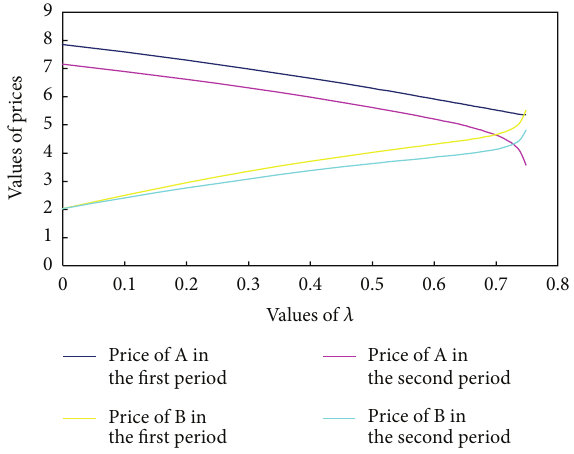
Figure 3: The sensitivity of optimal prices with respect to 𝛿